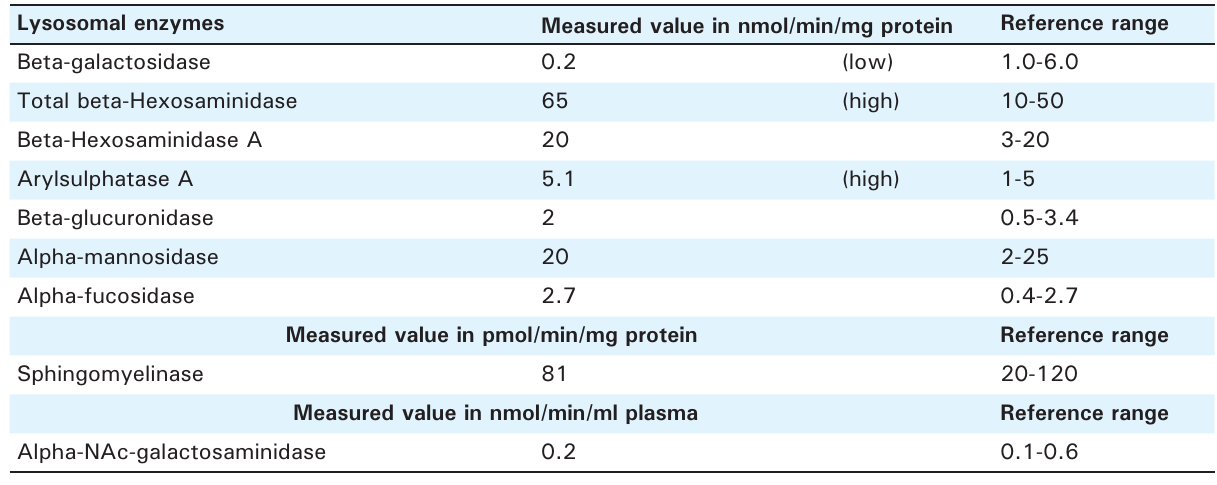
Table 1. Lysosomal Enzymes study of the child carried out in National Reference Laboratory in Australia. Specimen type: EDTA